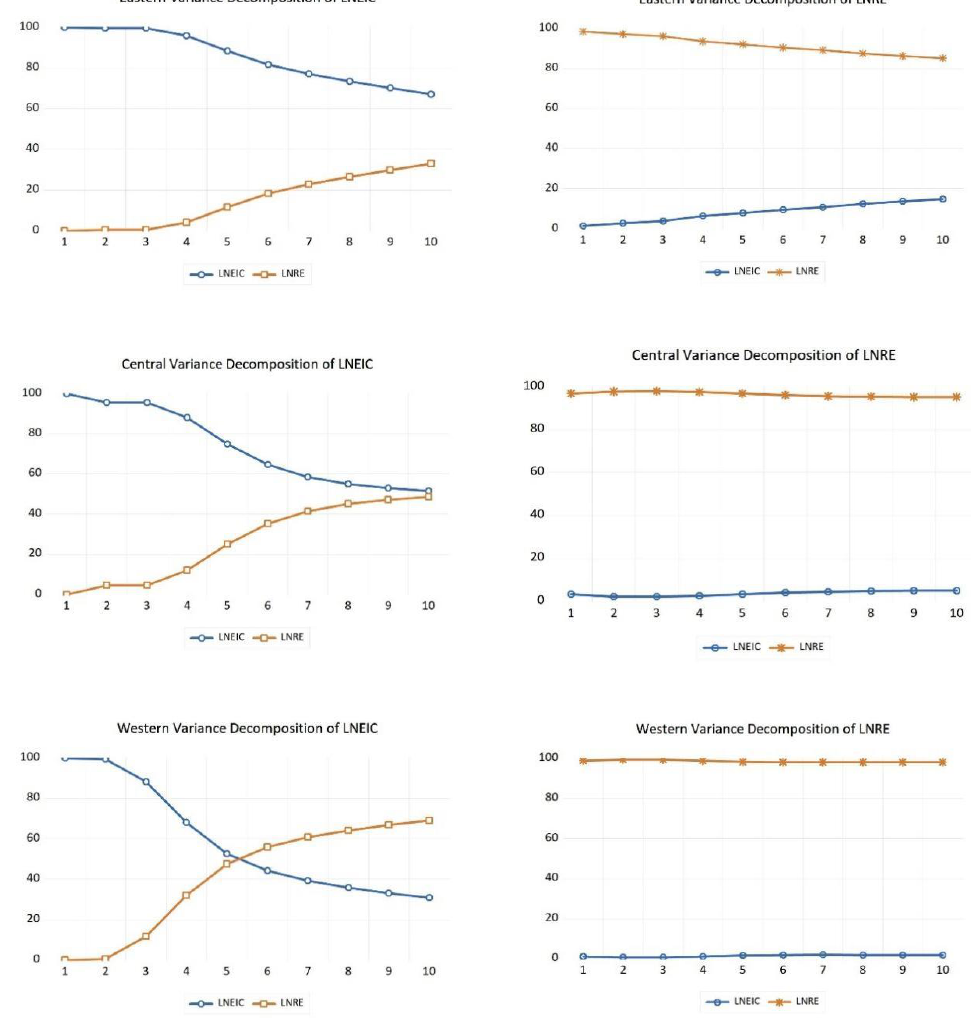
Figure 5. Variance decomposition results of the three economic regions.